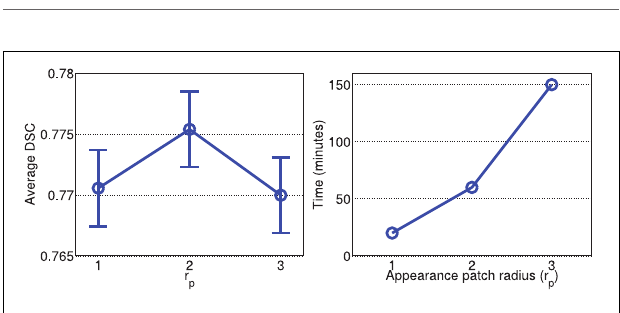
FIGURE 2 | Joint label fusion performance (Left: segmentation accuracy, error bars at ± 0.05 standard deviation; Right: average processing time) with respect to image patch size. Other parameters are set to r s = 3 , α = 0 . 1 , β = 2.